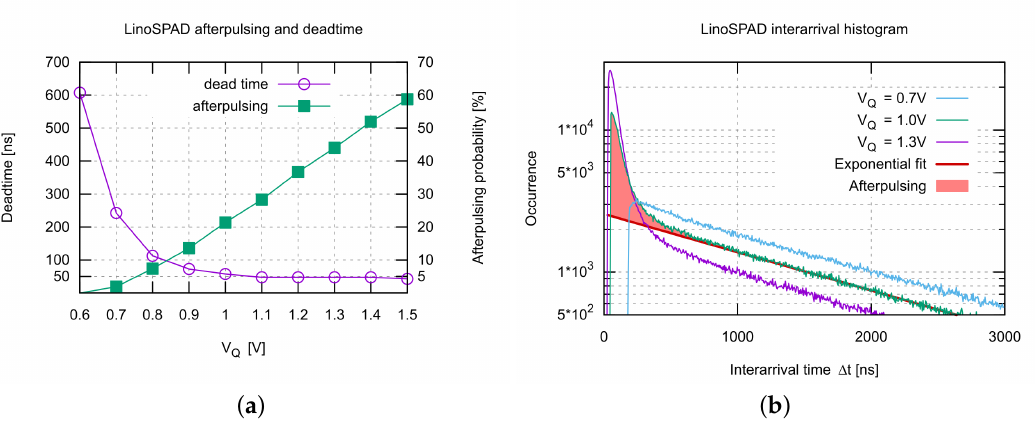
Figure 13. ( a ) Relationship between dead time and afterpulsing for the passively quenched LinoSPAD sensor; and ( b ) corresponding inter-arrival time histograms with clearly visible afterpulsing artifacts for higher quenching voltages, resulting in lower resistance and lower dead